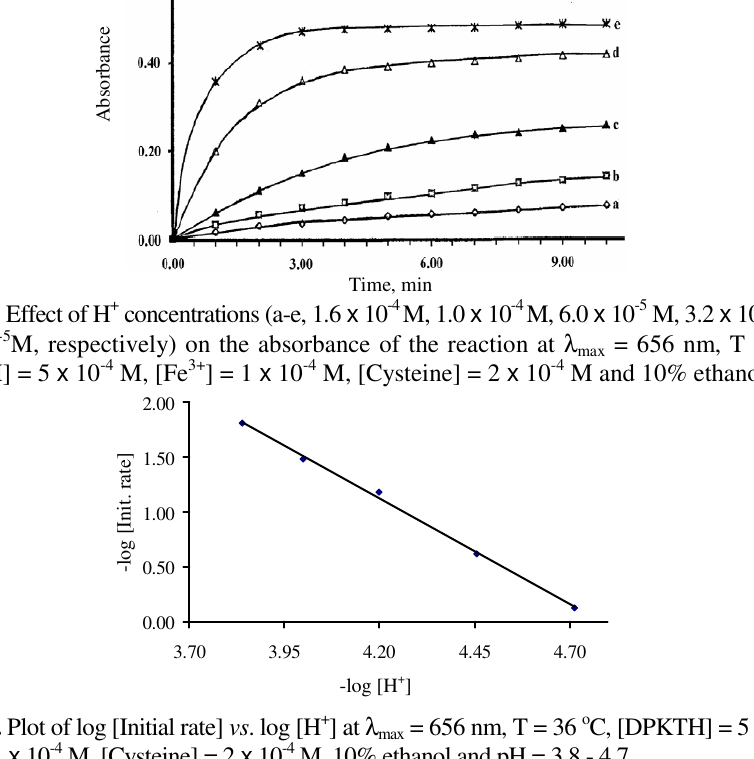
= 656 nm, T = 36 o C, [DPKTH] = 5 x 10 -4 M, max